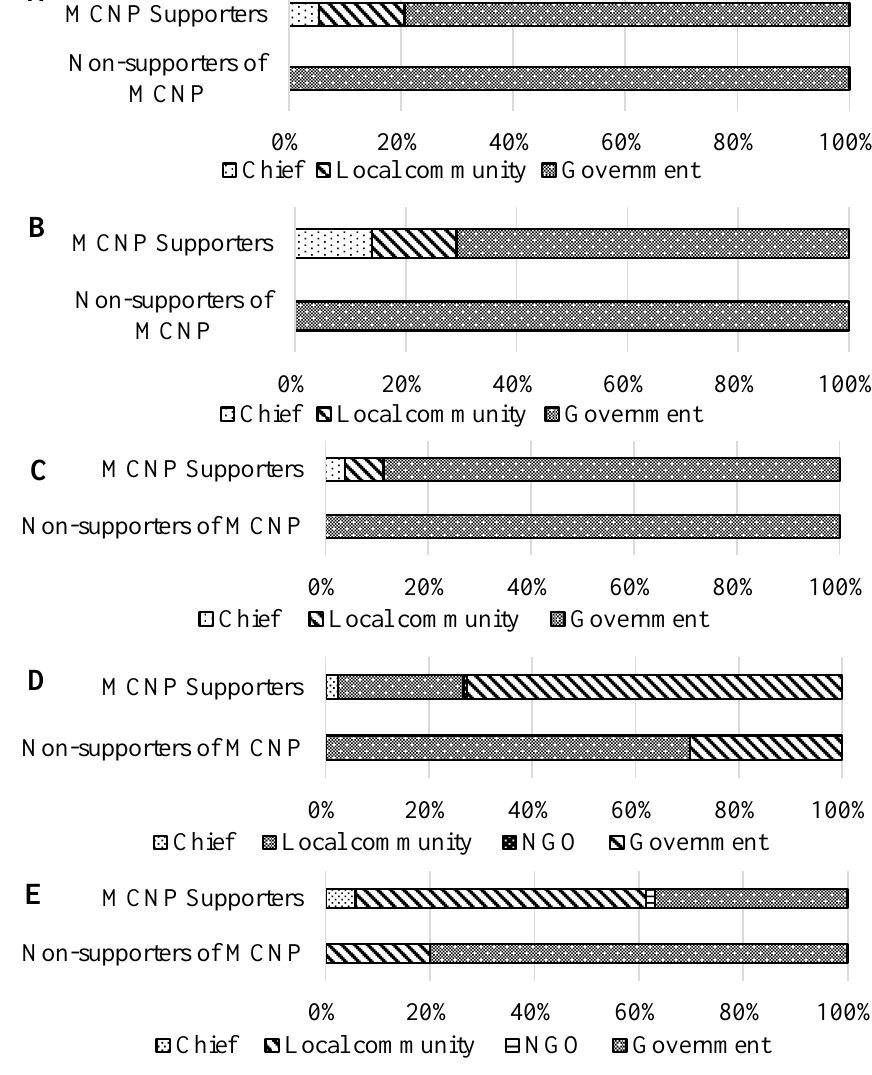
Figure 8. Variance of forest ownership ( A ), control ( B ), policy makers ( C ), cost bearers ( D ) and benefactors ( E ) between supporter and non-supporters of MCNP projects.